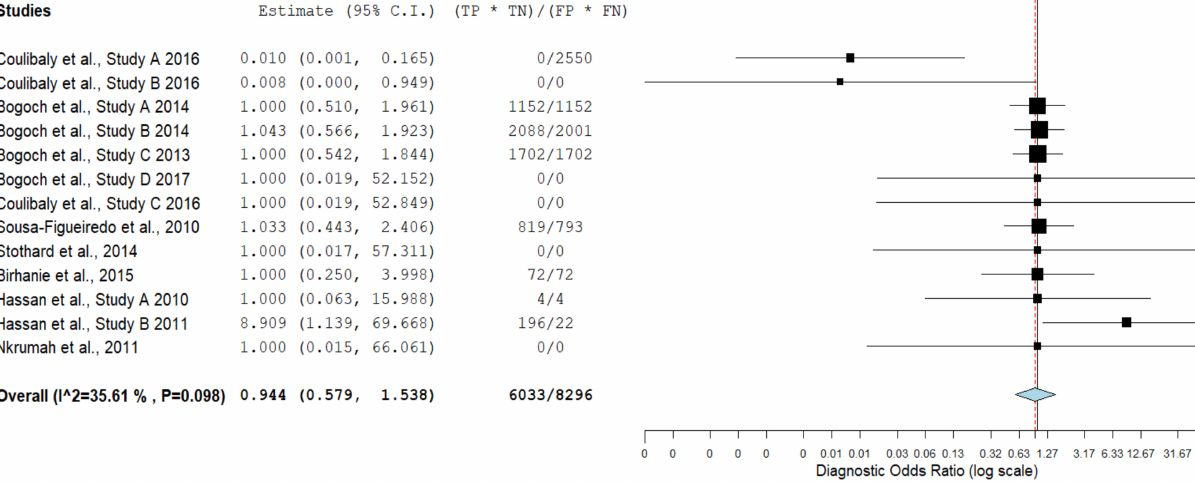
Figure 6. Diagnostic odds ratio forest plot of the included studies of mobile-linked diagnostic